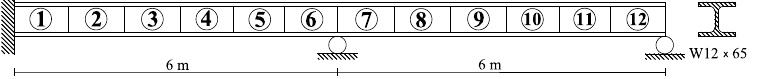
Fig. 2. Geometry of continuous